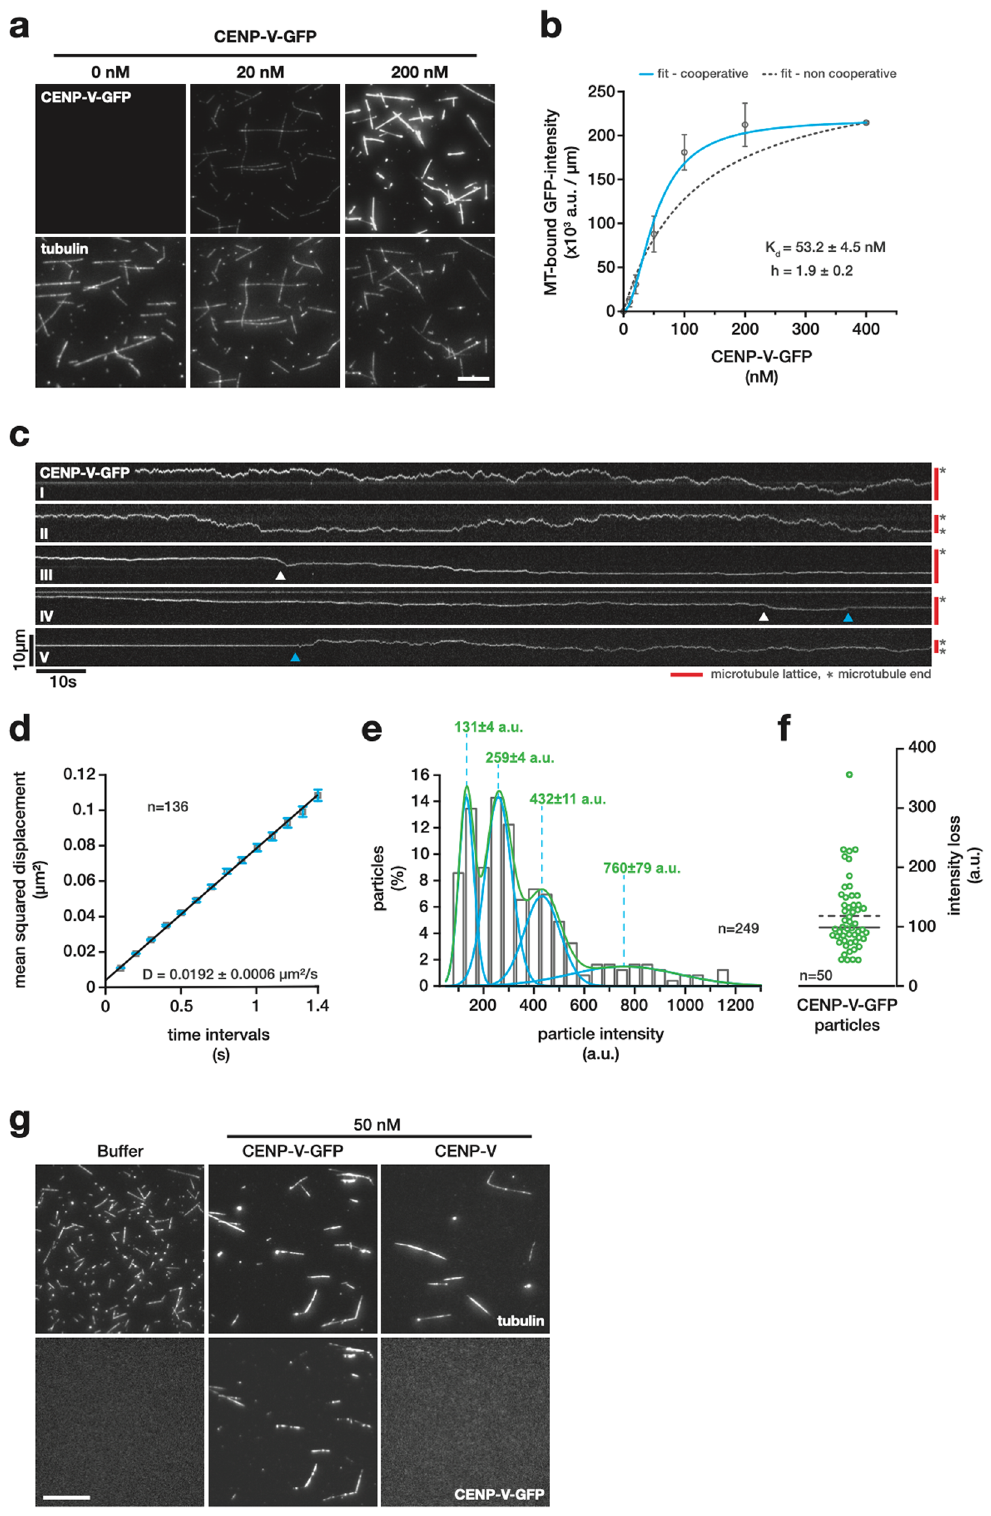
His 6 -CENP-V-eGFP in insect cells and puri fi ed the fusion protein by immobilised metal af fi nity and size exclusion chromatography (Supp. Figure 6). Biophysical properties of CENP-V were studied in vitro. We fi rst quanti fi ed the microtubule-binding capacity of CENP-V-eGFP, by titrating increasing amounts of protein onto surface-bound, taxol-stabilised ATTO 647N-labelled microtu- bules in 80 mM PIPES, pH 6.8, 1 mM MgCl 2 , 1 mM EGTA